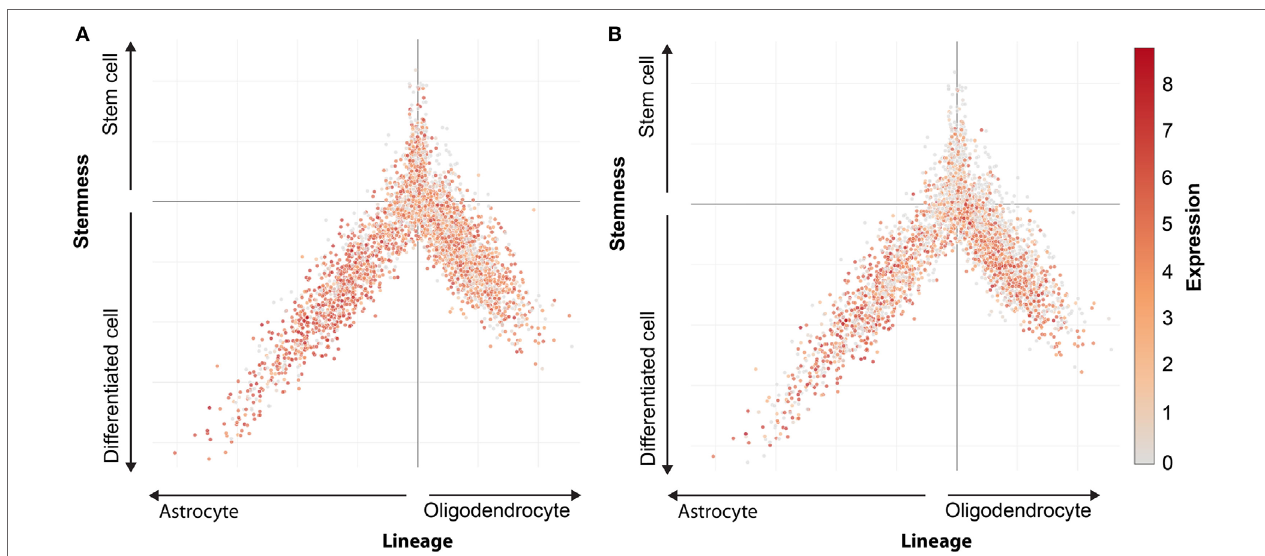
FiGUre 3 | HLA expression in oligodendroglioma. Expression pattern of HLA-A (a) and HLA-B (B) in oligodendrocytes, astrocytes, and cancer stem cells. Every dot represents a single cells. Oligodendrocytes lineage (positive X, negative Y), astrocytes lineage (negative X, negative Y), and stem cells (positive Y). Expression level indicated by colors from gray (low expression) to red (high expression).